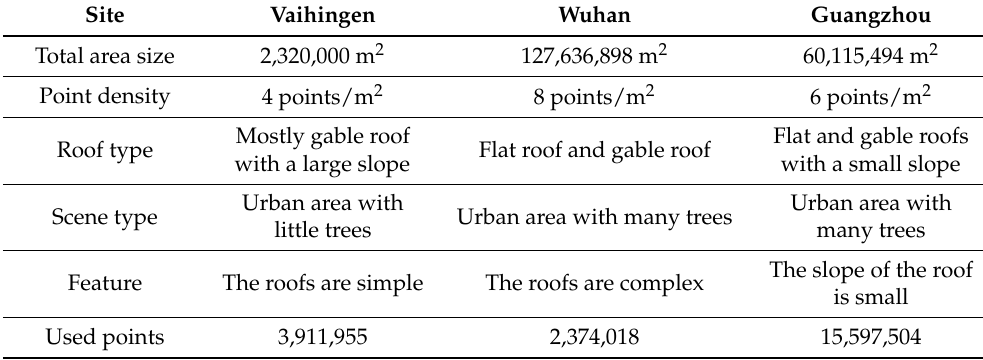
Table 1. Descriptions of test data.